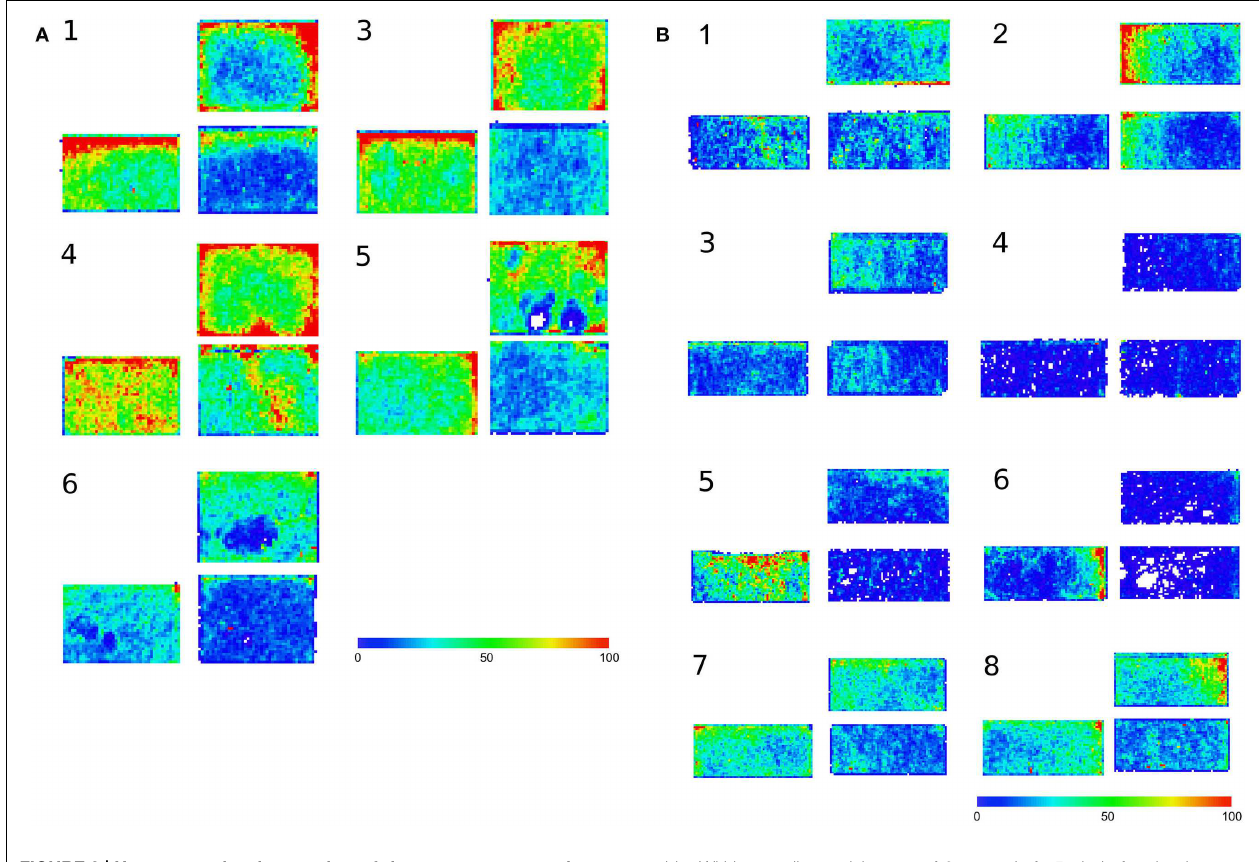
side. Within a replicate trial group of 3 maps: Left: 5min before barrier was opened, Area 1. Right: 5min after barrier was opened. Bottom: Area 1. Top: Area